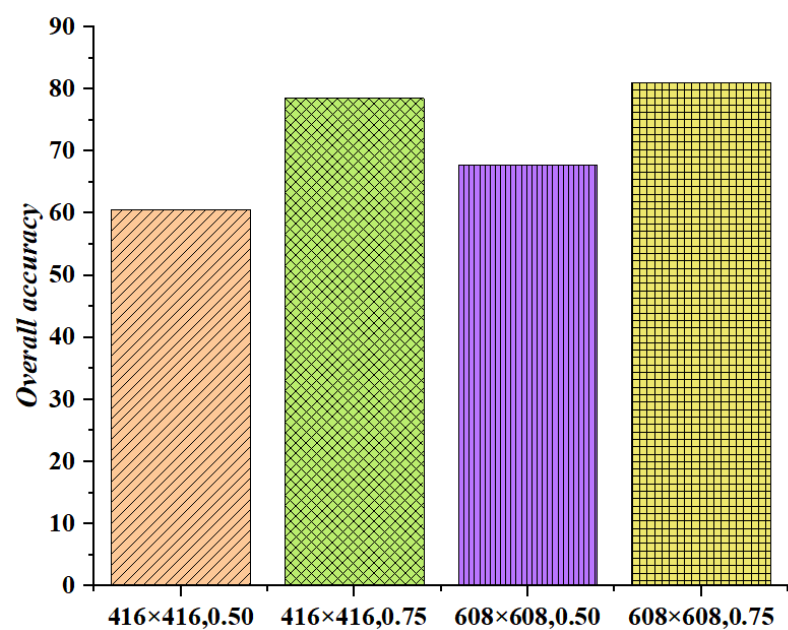
Figure 16. Overall accuracy ( OA ).